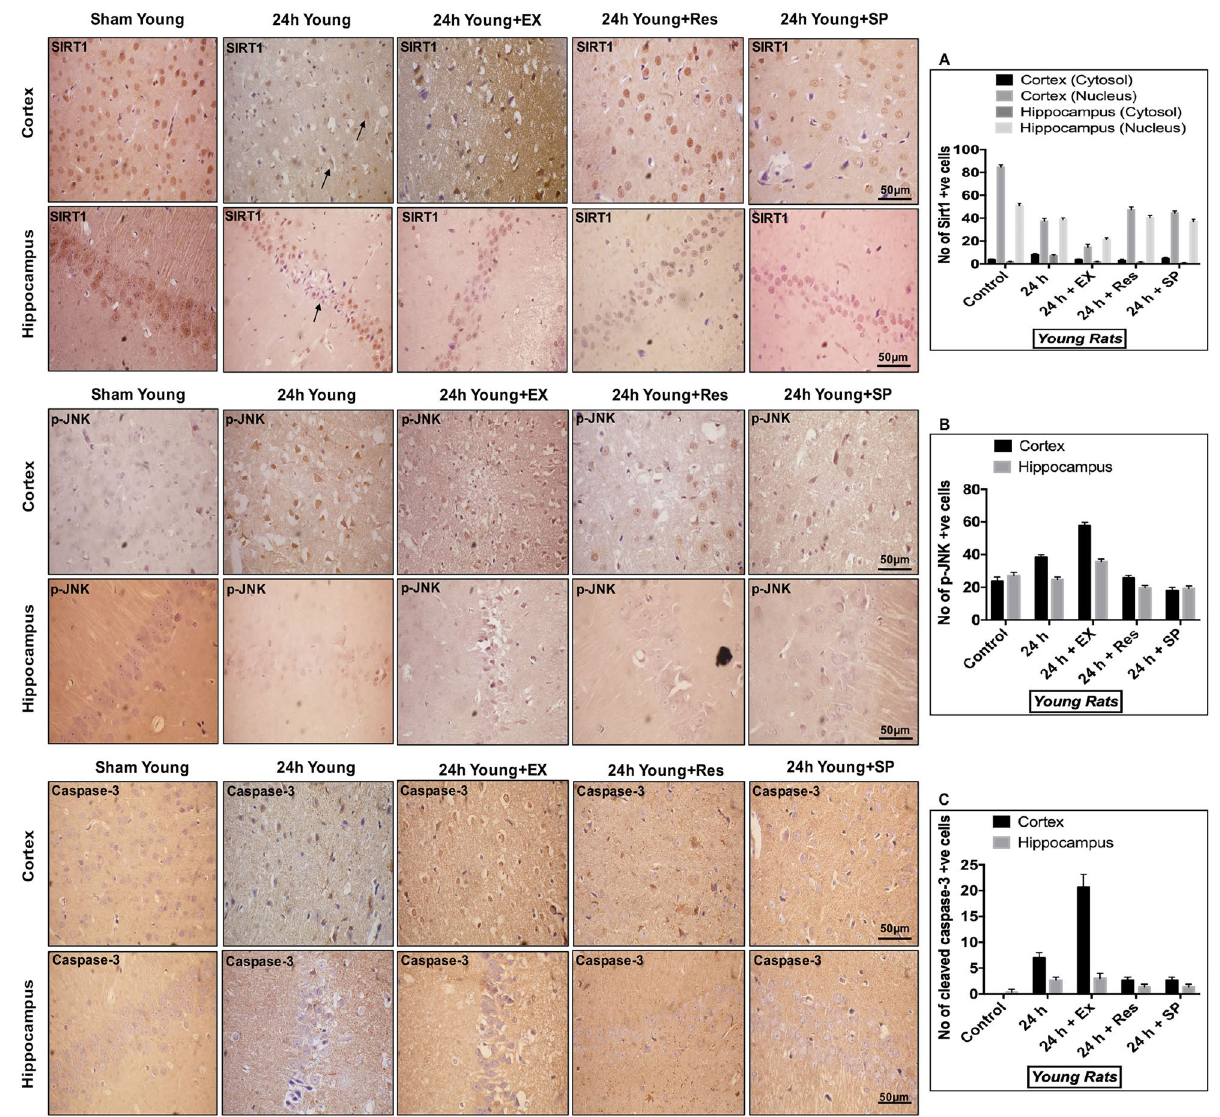
Figure 4. Subcellular localization of SIRT1, p-JNK, & caspase-3 in young rats following CI. Young rat brains were paraffin embedded and sectioned into 5–10 μm thick slices (n = 4). (A) Subcellular distribution of SIRT1 in the brains of young rat cortex and hippocampus neurons from sham control as well as brains from 24 h after MCAO, MCAO + EX-527, MCAO + resveratrol, and MCAO + SP600125 treatment. (B) p-JNK immunoreactivity in the brains of young rat cortex and hippocampus neurons from control as well as brains from 24 h after MCAO, MCAO + EX-527, MCAO + resveratrol, and MCAO + SP600125 treatment. (C) Nuclear immunoreactivity of activated caspase-3 in the brains of young rat cortex and hippocampus neurons from control as well as brains from 24 h after MCAO, MCAO + EX-527, MCAO + resveratrol, and MCAO + SP600125 treatment (magnification 400X; Scale Bar—50 μm). Immunoreactivity for SIRT1, p-JNK, and caspase-3 was depicted in brown (DAB). The neuronal nucleus is visualized with Hematoxylin tion of SIRT1 increased phosphorylation of MAPKs, including JNK, MEK, and ERK (p-MEK–p < 0.001, SIRT1- p < 0.004; Fig. 1G–J). The amount of infarct was measured using TTC staining, and reduction in infarct was not significant enough in resveratrol-treated ischemic aged rats compared with the MCAO group (Fig. 2D). Further- more, increased immunoreactivity was seen against SIRT1 and p-JNK after resveratrol treatment compared to the MCAO group (Fig. 3A,B). Caspase-3 immunoreactivity was also assessed to confirm if the neuroprotective effect of resveratrol in aged experimental rats is associated with the downregulation of apoptosis. No significant decrease in caspase-3 immunoreactivity was observed (Fig. 3C). In this connection, there was no significant decrease in the number of FJ-C positive cells in the resveratrol-treated group compared with the MCAO group (Fig. 6).